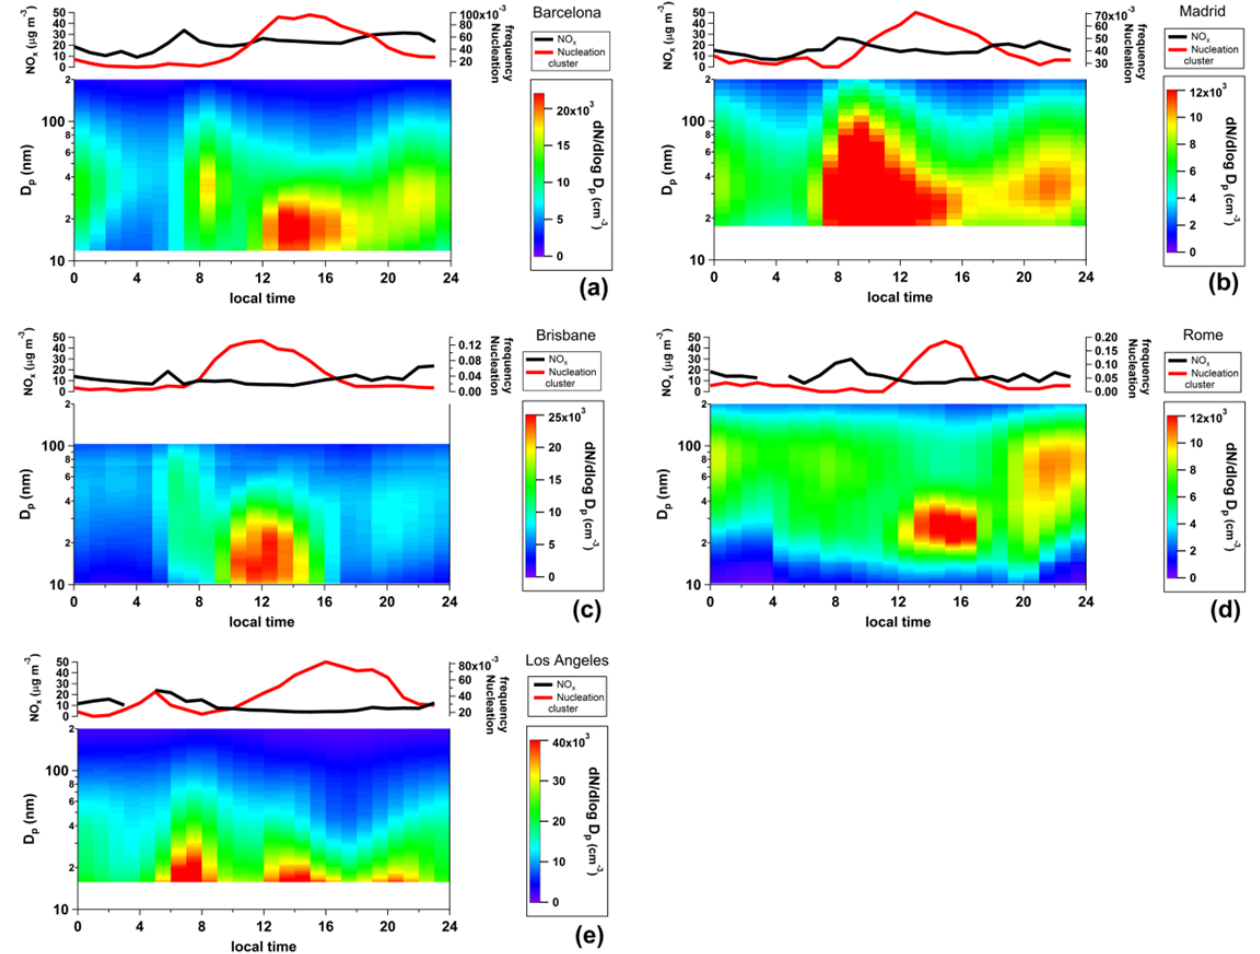
Figure 5. Mean SMPS size distributions on a nucleation day at each selected city, NO x average concentration and the frequency of occurrence of the Nucleation cluster for: (a) Barcelona, (b) Madrid, (c) Brisbane, (d) Rome and (e) Los Angeles. Please note that NO x concentrations for Madrid represent NO x / 2 and for Los Angeles NO x / 10. These values are 30–65% lower on nucleation days than the corresponding sampling period average